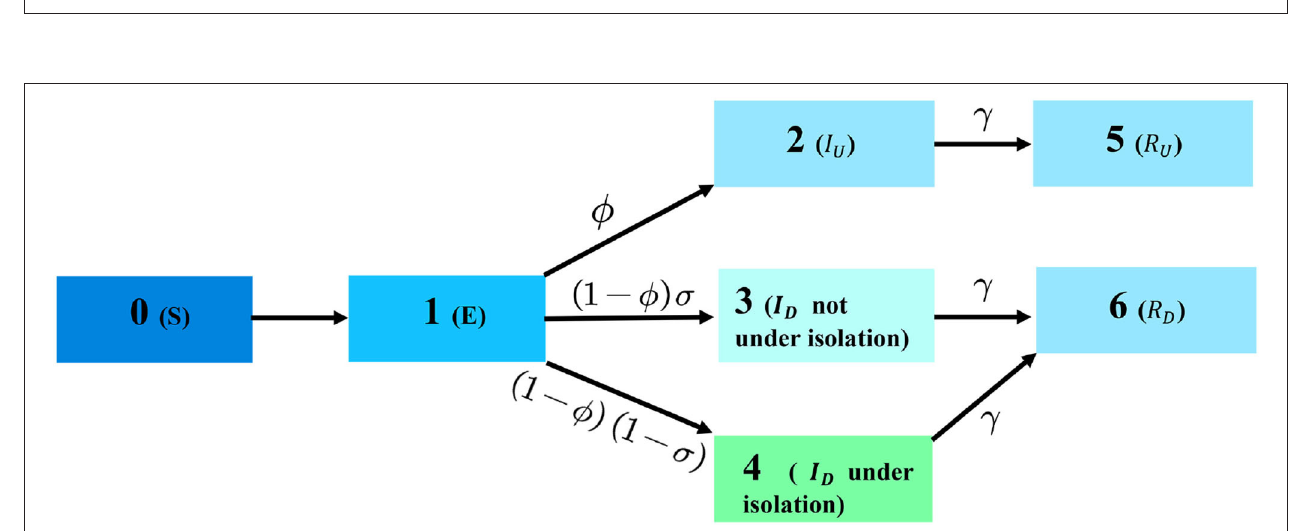
FIGURE 4 | The framework of